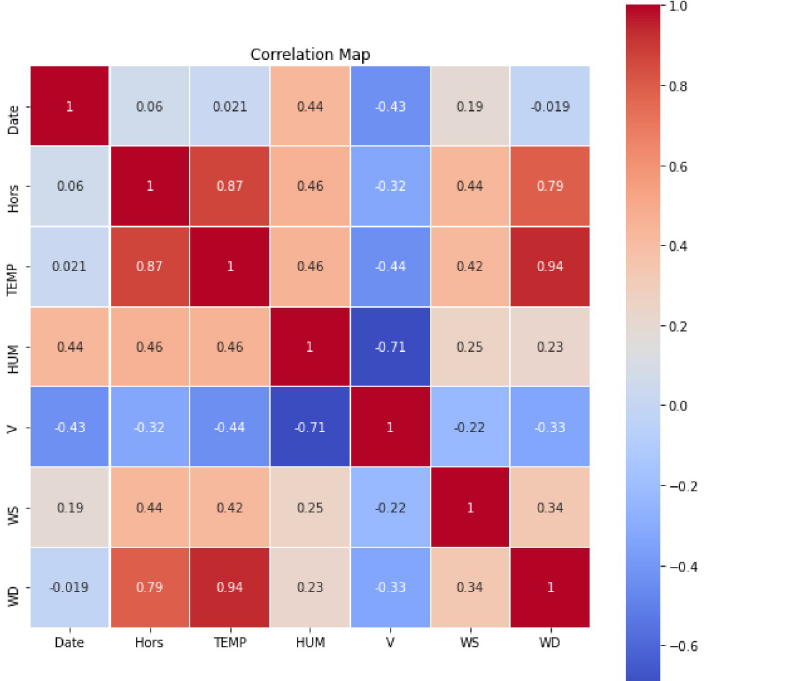
Fig 2. The correlation between the features of the